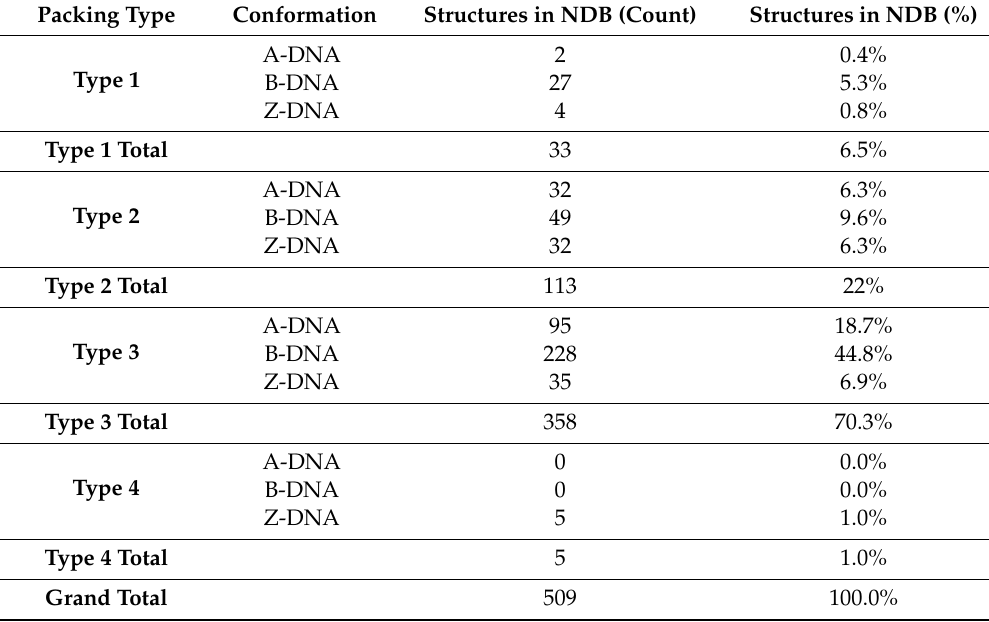
Table 2. Number and proportion of DNA structures belonging to different packing types and their